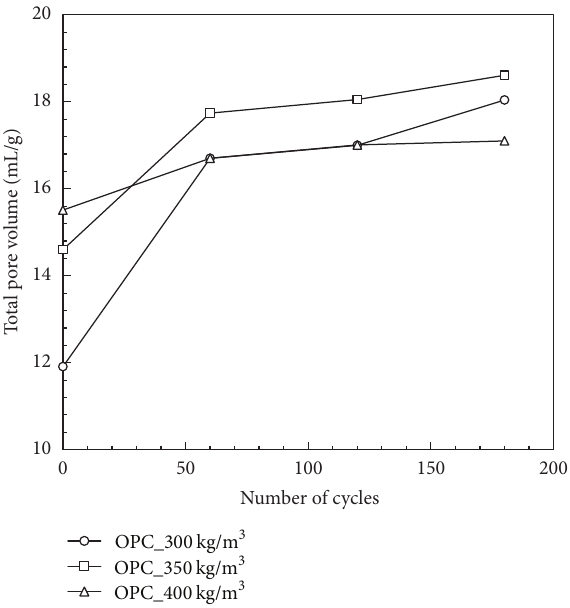
Figure 3: Total pore volume for 300, 350, and 400 kg/m 3 of cement content at 0, 60, 120, and 180